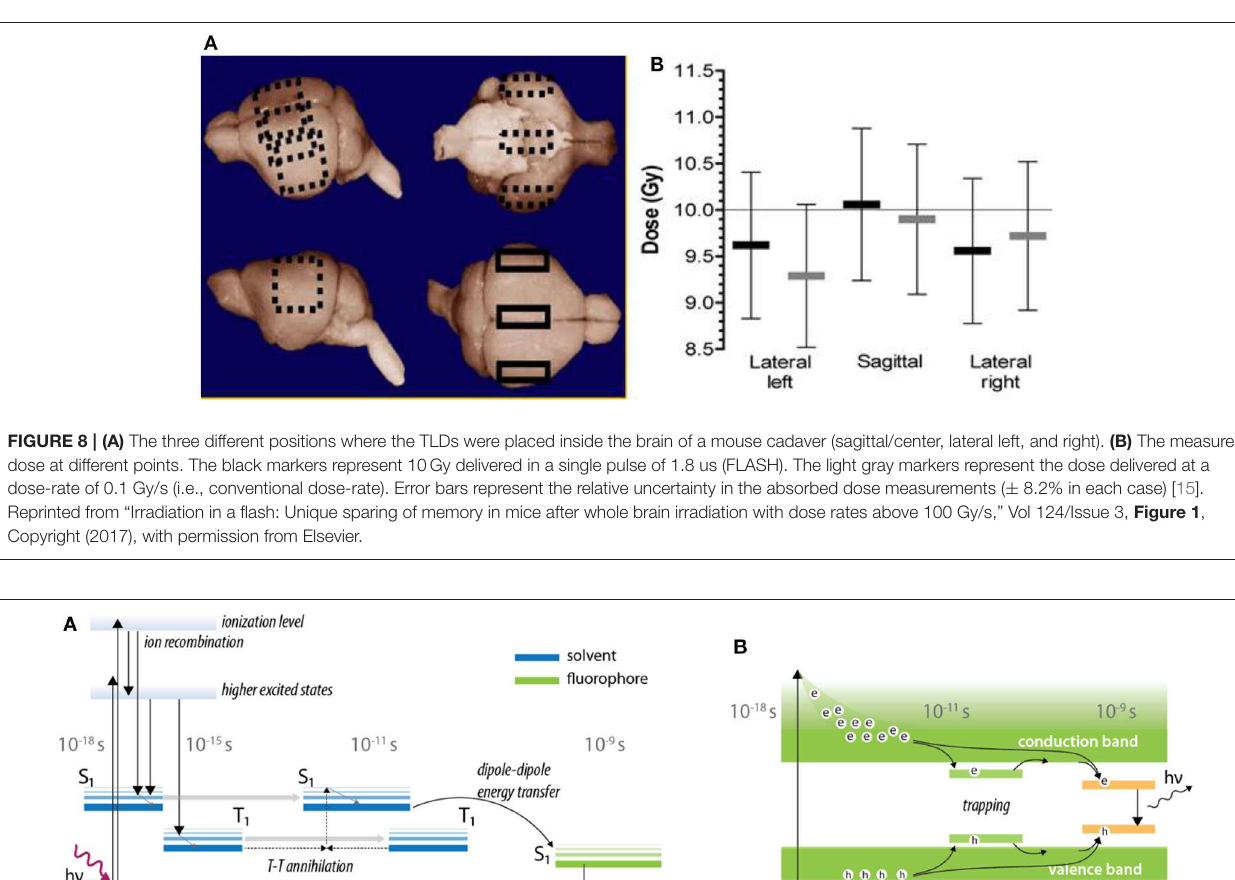
dose. The field homogeneity and FWHM values measured by rates. Peak dose-rate used in the study was around 2.4–3.5